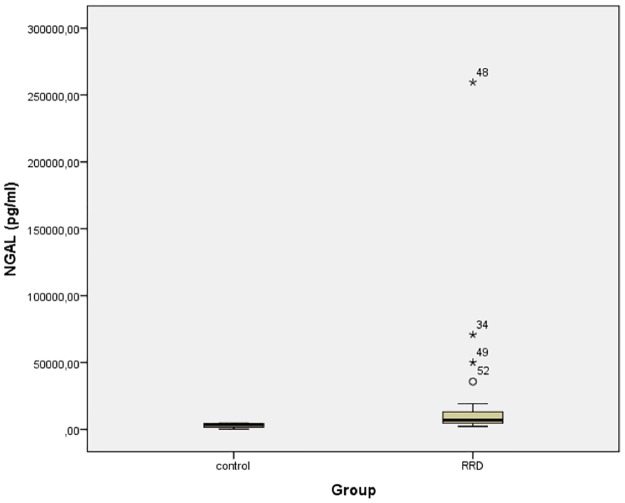
LCN2 (NGAL) levels of the patients and the controls (U = 27, p<0.001).Circles denote mild outliers and asterisks denote extreme outliers.